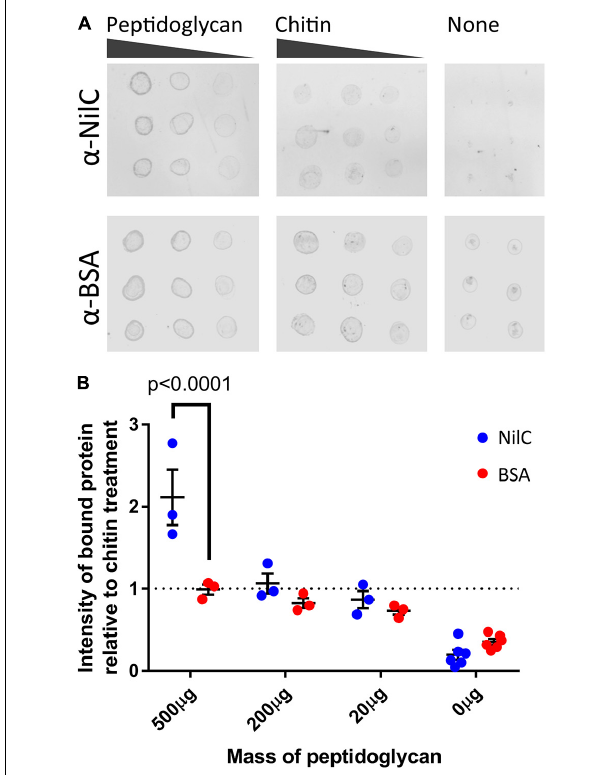
FIGURE 8 | NilC binds peptidoglycan. (A) Immuno-dot blots depicting the amount of NilC or bovine serum albumin (BSA) bound to B. subtilis peptidoglycan or chitin after an hour of incubation. Three different concentrations of peptidoglycan and chitin were used to provide a gradient (horizontal dots), and 2 µ l of each reaction were spotted in triplicate (vertical dots). Immunoblots were probed with the indicated primary antibodies and then labeled with an α -rabbit IgG antibody conjugated to a 680-nm fluorophore for imaging. (B) To visualize peptidoglycan binding, protein intensity values were normalized to the average intensity of protein in the chitin samples and plotted. Error bars depict the standard error of each mean. A Tukey’s honest significance test was used to compare NilC and BSA intensities; a Dunnett’s test was used to compare peptidoglycan-associated protein intensities to chitin-associated protein